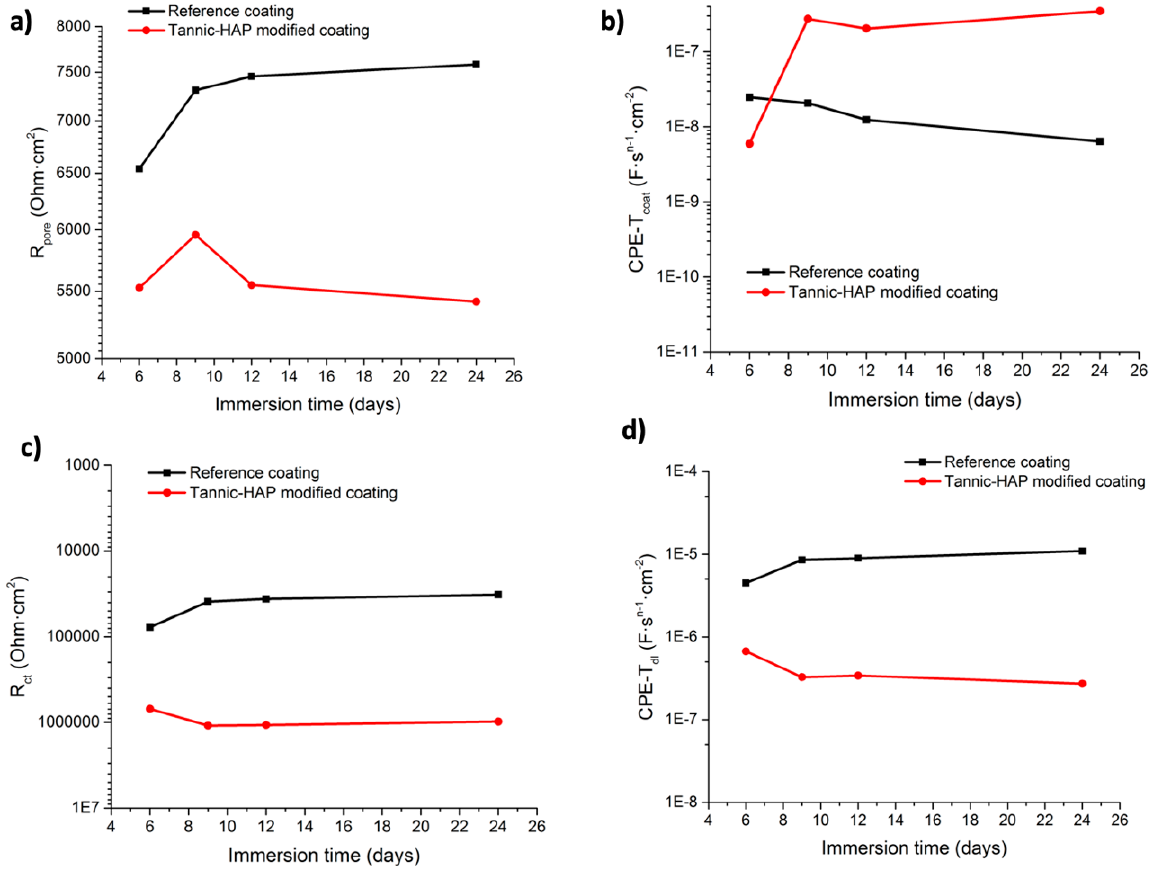
Figure 7. Evolution of the fitting parameters extracted from the numerical simulation of the experimental EIS data: ( a ) pore resistance; ( b ) admittance of the CPE for the coating; ( c ) charge transfer resistance; ( d ) admittance of the low-frequency CPE.